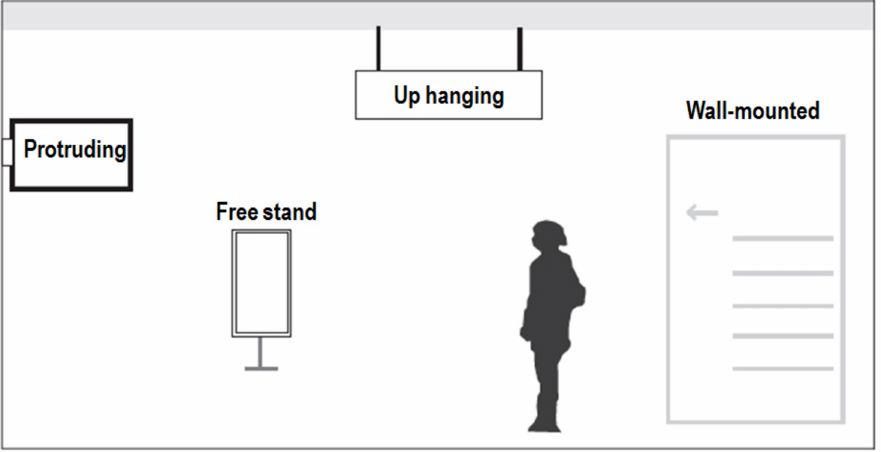
Figure 4. Classification of the forms of the signage in the research